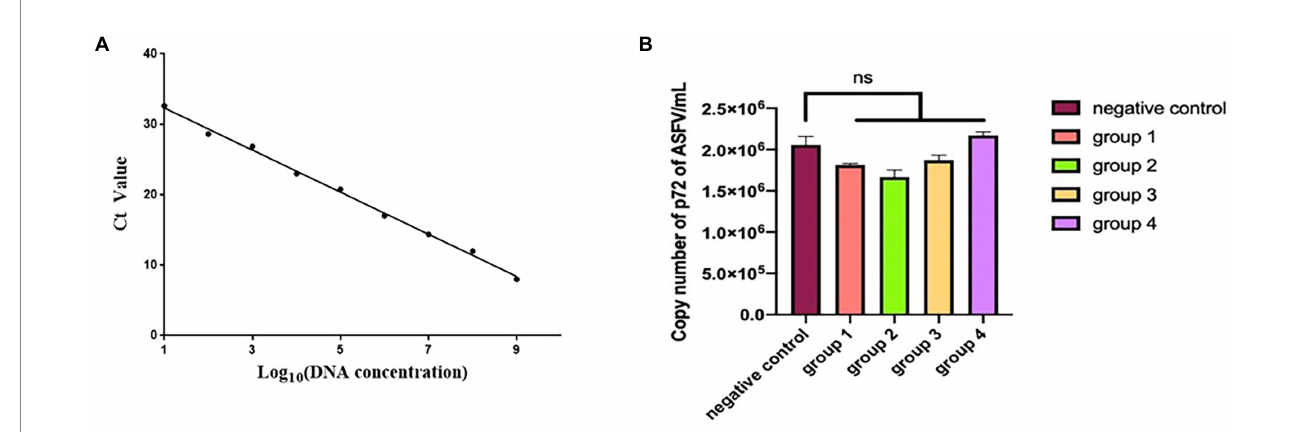
FIGURE 8 (A) Linear regression between the logarithmic value of plasmid concentration and Ct. (B) The number of copies of B646L gene was measured in group 1–4. Group 1 is the mixture of mAbs 6D6D9 (identify epitope 3) + 2B8F7 (identify epitope 6) and ASFV CN/SC/2019 (200 TCID 50 ). Group 2 is the mixture of mAbs 4F6D4 (identify epitope 4) + 2C9D6 (identify epitope 7) and ASFV CN/SC/2019 (200 TCID 50 ). Group 3 is the mixture of mAbs 4E10B3 (identify epitope 1) + 6H2C5 (identify epitope 2) and ASFV CN/SC/2019 (200 TCID 50 ). Group 4 is the mixture of mAb 3D4A9 (identify epitope 5) and ASFV CN/SC/2019 (200 TCID 50 ). Each virus-mAb mixture was incubated overnight at 4 ° C, inoculated into PAMs, and allowed to adsorb for 1 h. PAMs were cultured for 72 h and the ASFV genome was extracted and amplified by qPCR.